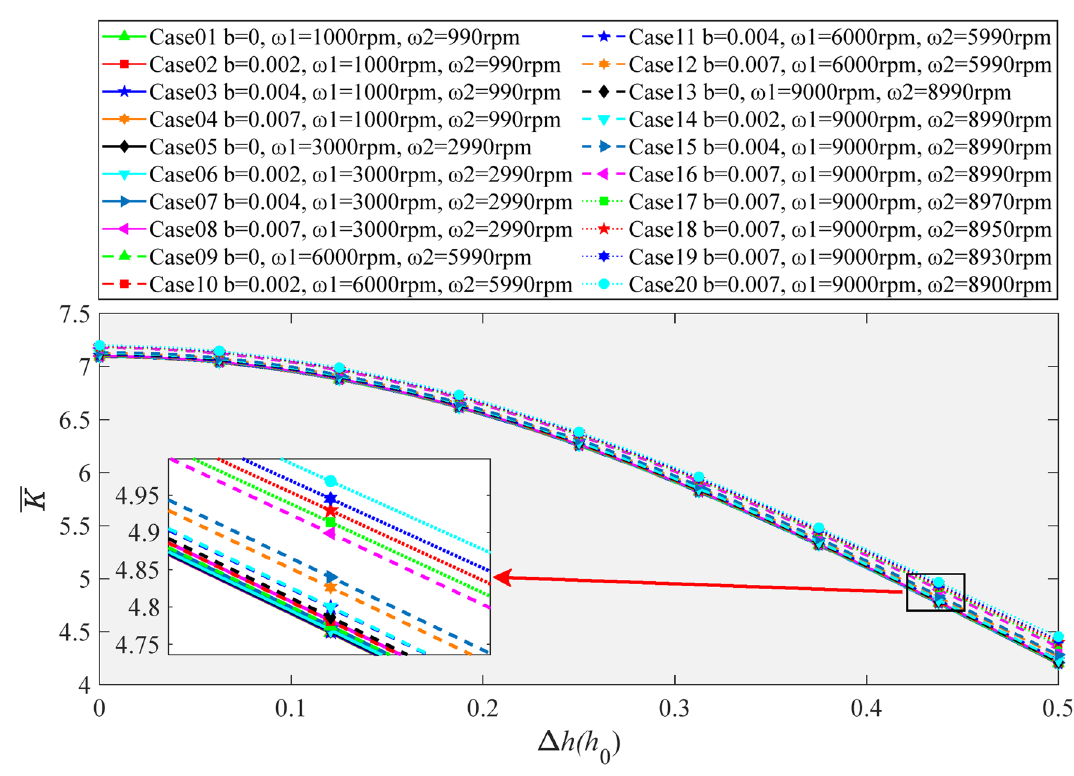
Figure 16. Influence of boundary slip on oil film stiffness (Operation in dual drive differential